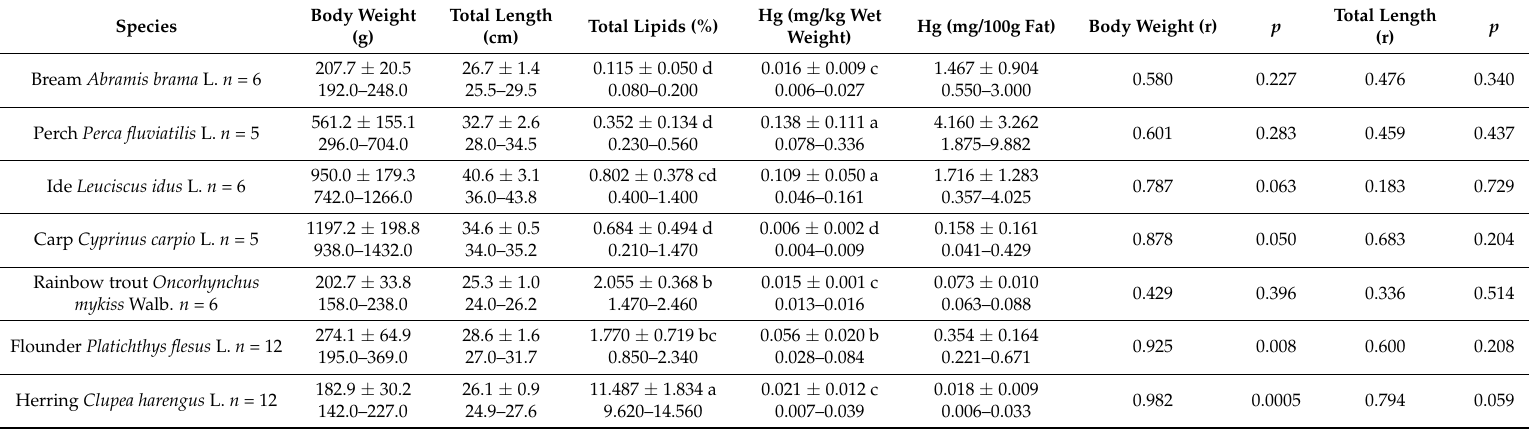
Table 1. Mercury and total lipids content (mean ± SD, range), and linear correlation coefficients (r) between body weight or total length and content of mercury in muscles of fish.